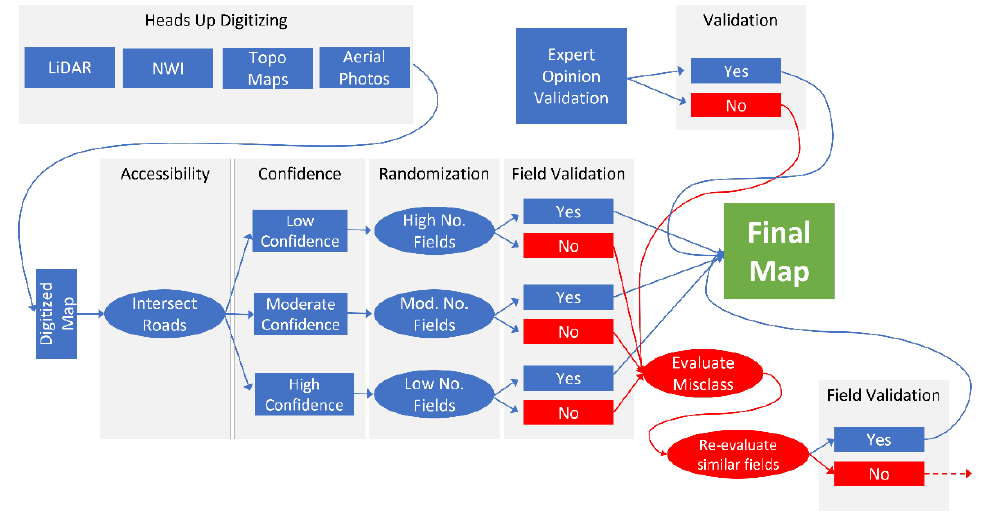
Figure 2. A systematic and reproducible conceptual model was developed to ensure a robust subset of rice fields were selected for field validation. of rice fields were selected for field